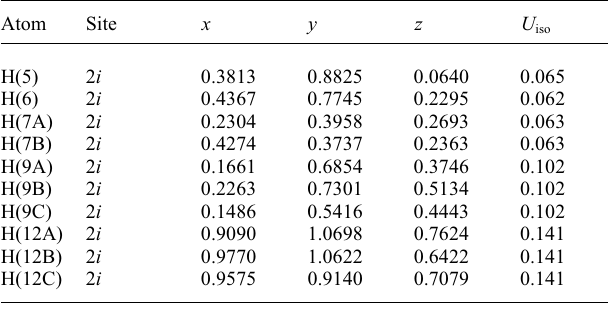
Table 3. Atomic coordinates and displacement parameters (in Å 2 )